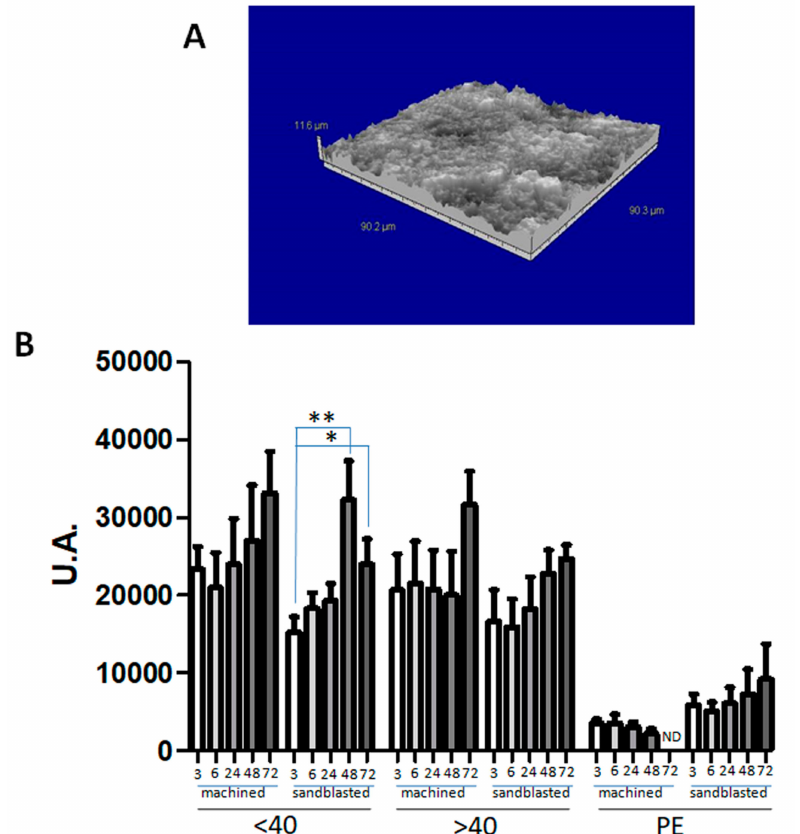
Figure5. AdhesionofhAMSCstotitaniumdisks. Panel( A )showsasurfaceviewofthesandblasteddisk, obtained by the rugosimeter software. Panel ( B ) illustrates the results obtained when CM-DiL-labelled cells (p2) obtained from Group 1 ( < 40), Group 2 ( > 40), or Group 3 (PE) were seeded on machined (smooth) or sandblasted titanium disks, and associated fluorescence was assessed at 3, 6, 24, 48, and 72 h. ND: not determined. Results are expressed as mean ± SD of three experiments carried out each in triplicate for each isolate. * P < 0.05; ** P <